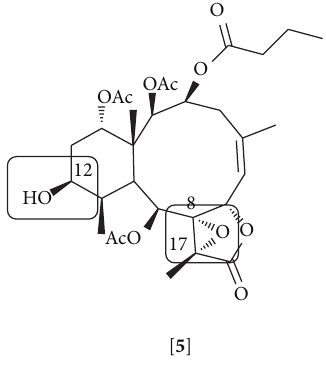
Figure 3: Structure of excavatolide B [ 5 ]. The 8,17-epoxide and 12- hydroxyl groups that have been suggested as being responsible for the anti-inflammatory effect are